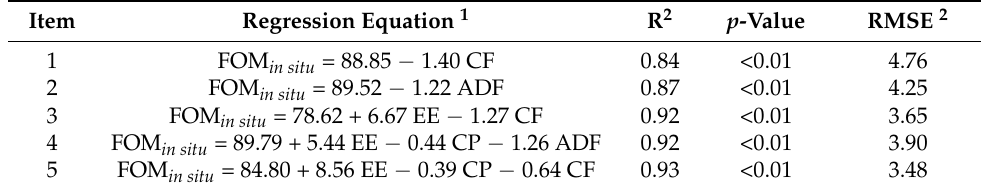
Table 3. Prediction equations between FOM in situ and chemical compositions of roughages.